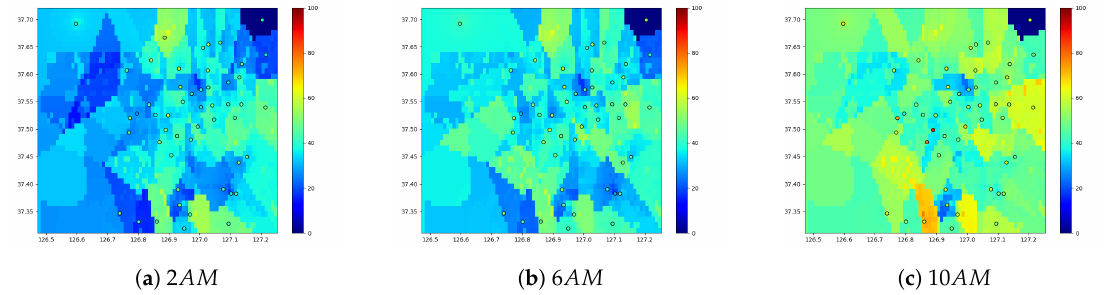
Figure 7. PM2.5 prediction at 45th day in 2018 over our grid.